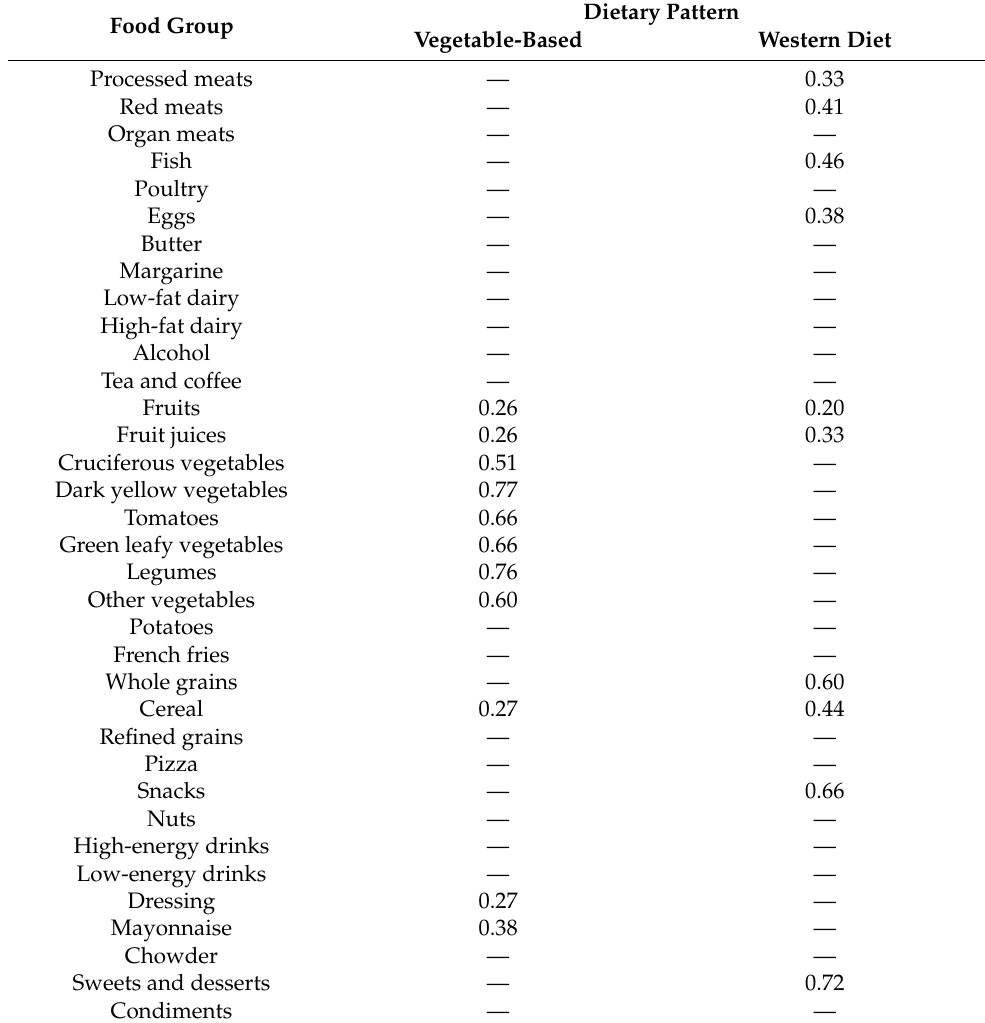
Table 2. Factor loading matrix for major dietary patterns a